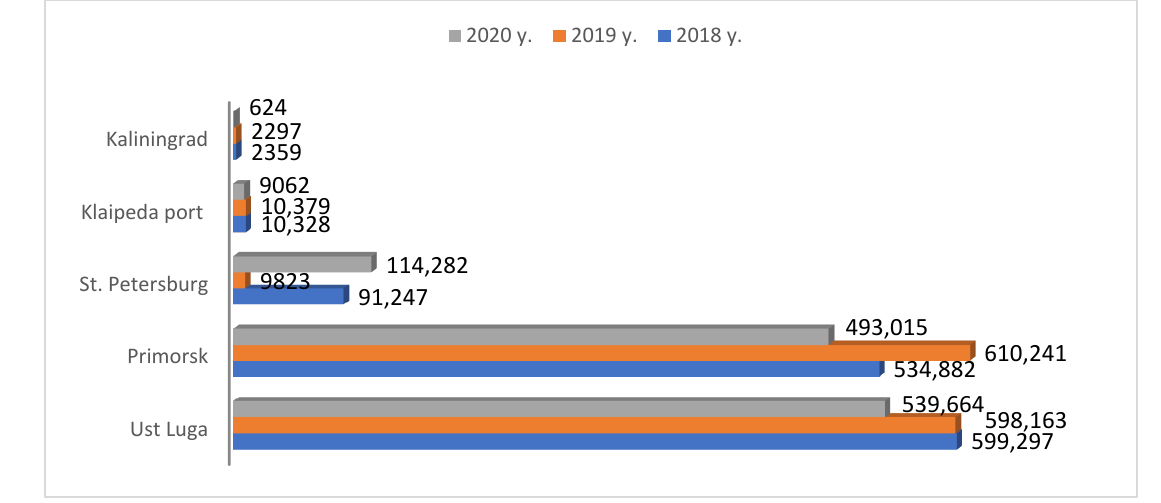
Figure 20. Largest oil handling ports in the Baltic region, thousand tons.